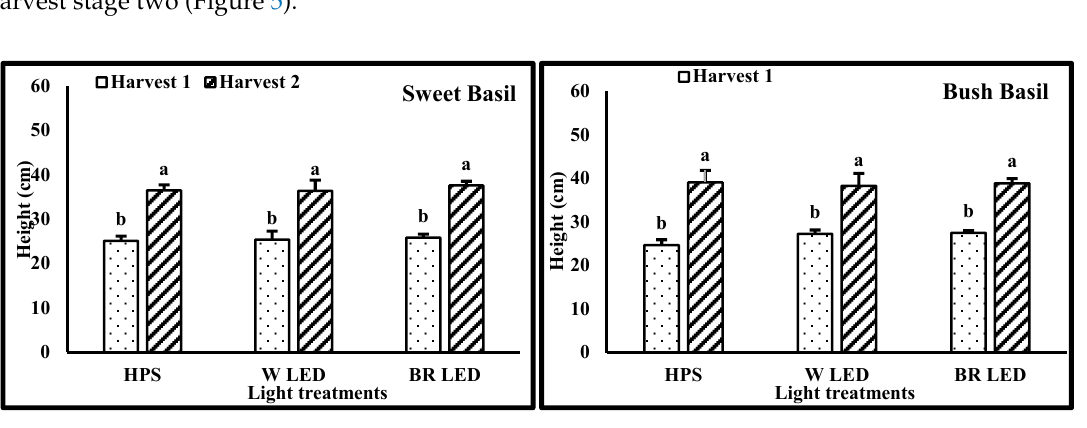
Figure 5. The effect of light treatments and harvest stage on the height of sweet basil (LSD = 2.06 for the harvest stage) and bush basil (LSD = 2.4 for the harvest stage). Different letters denote significant differences between treatments ( p < 0.01).